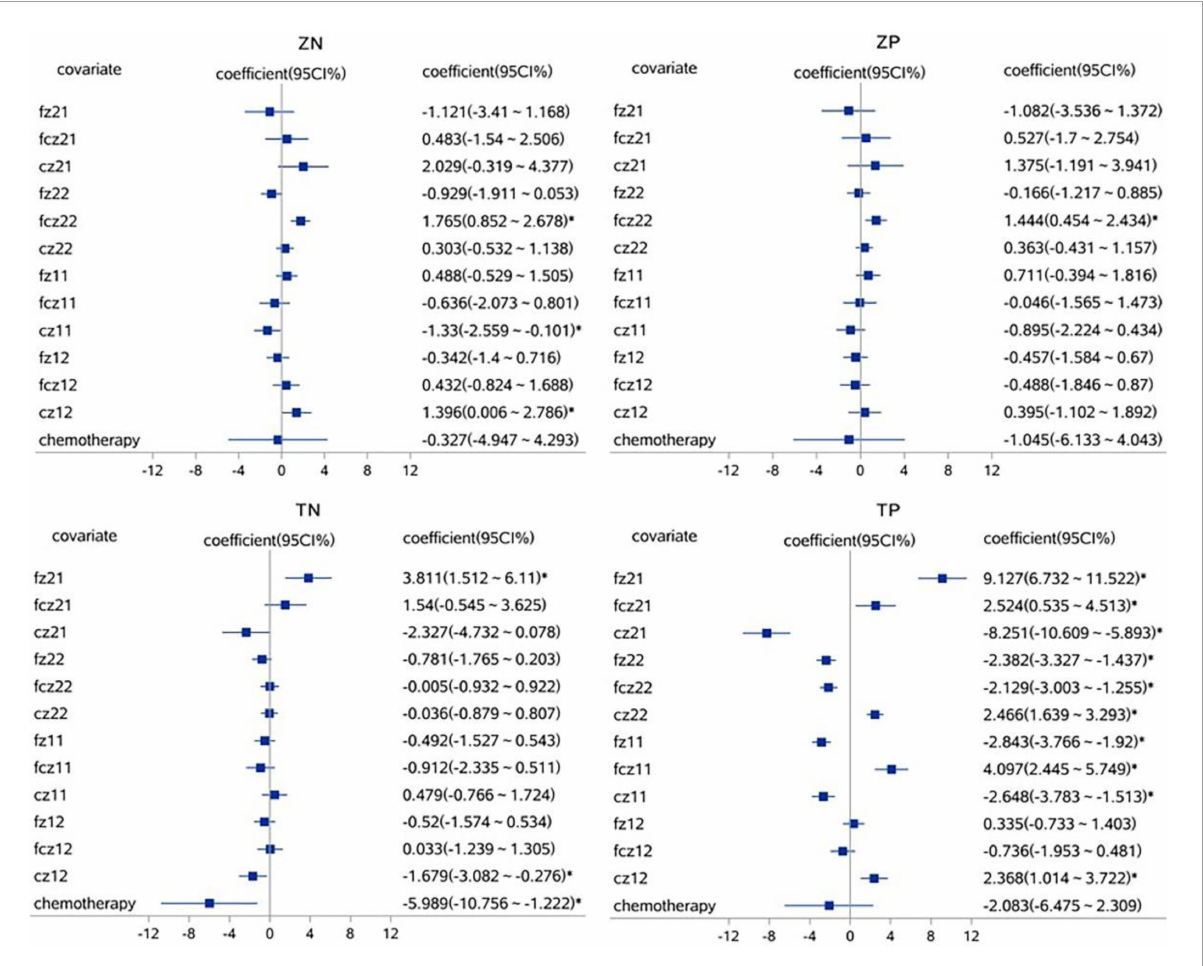
FIGURE3 The correlations analysis between ERP N1 component and accuracy rates on pain empathy paradigm. * P < 0.05, linear mixed effect model, when 95% confidence interval (95 CI%) contained no 0 in the forest plots, that is, the minimum value for the interval was positive or the maximum was negative, then P < 0.05. fz, fcz, and cz were defined as electrode points for ERP. Z, laterality tasks; T, pain task; N, neutral picture stimulation; P, pain picture stimulation. 21, laterality tasks + pain picture stimulation; 22, laterality tasks + neutral picture stimulation; 11, pain task + pain picture stimulation; 12, pain task + neutral picture